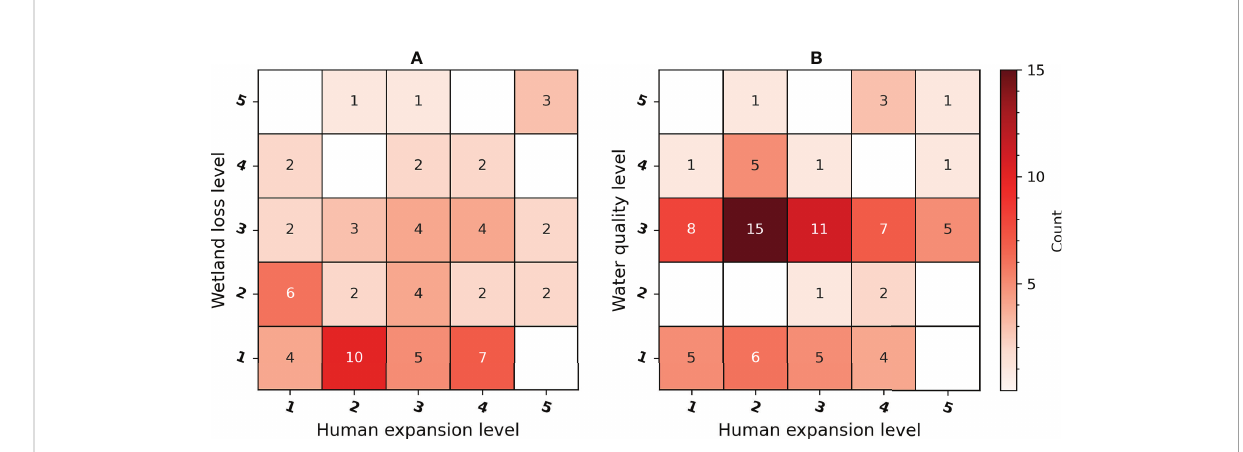
FIGURE 7 The correlation (frequency) heatmap between human expansion and environmental change: (A) wetland loss, (B) water environmental